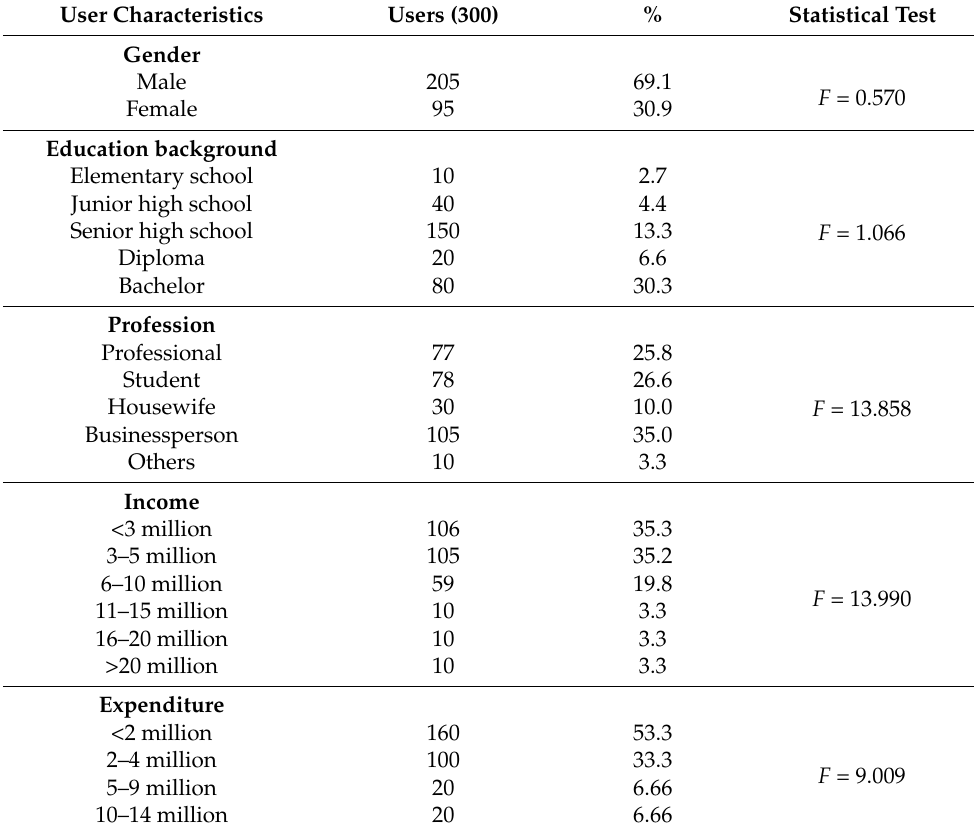
Table 1. Demographics for all the